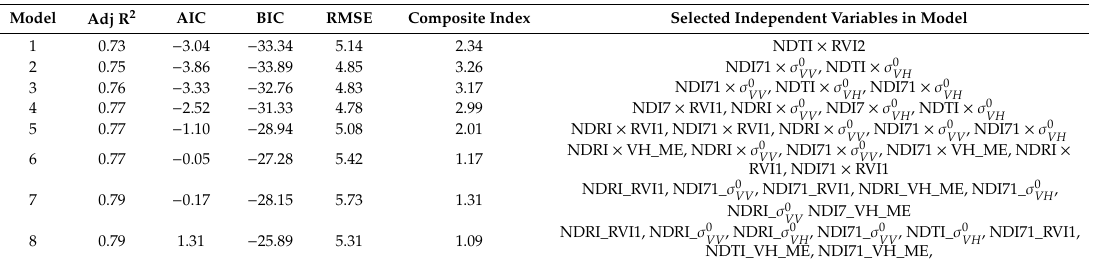
Table 5. Alternative submodels and evaluation indexes of OCRI-RPs by optimal subset regression.